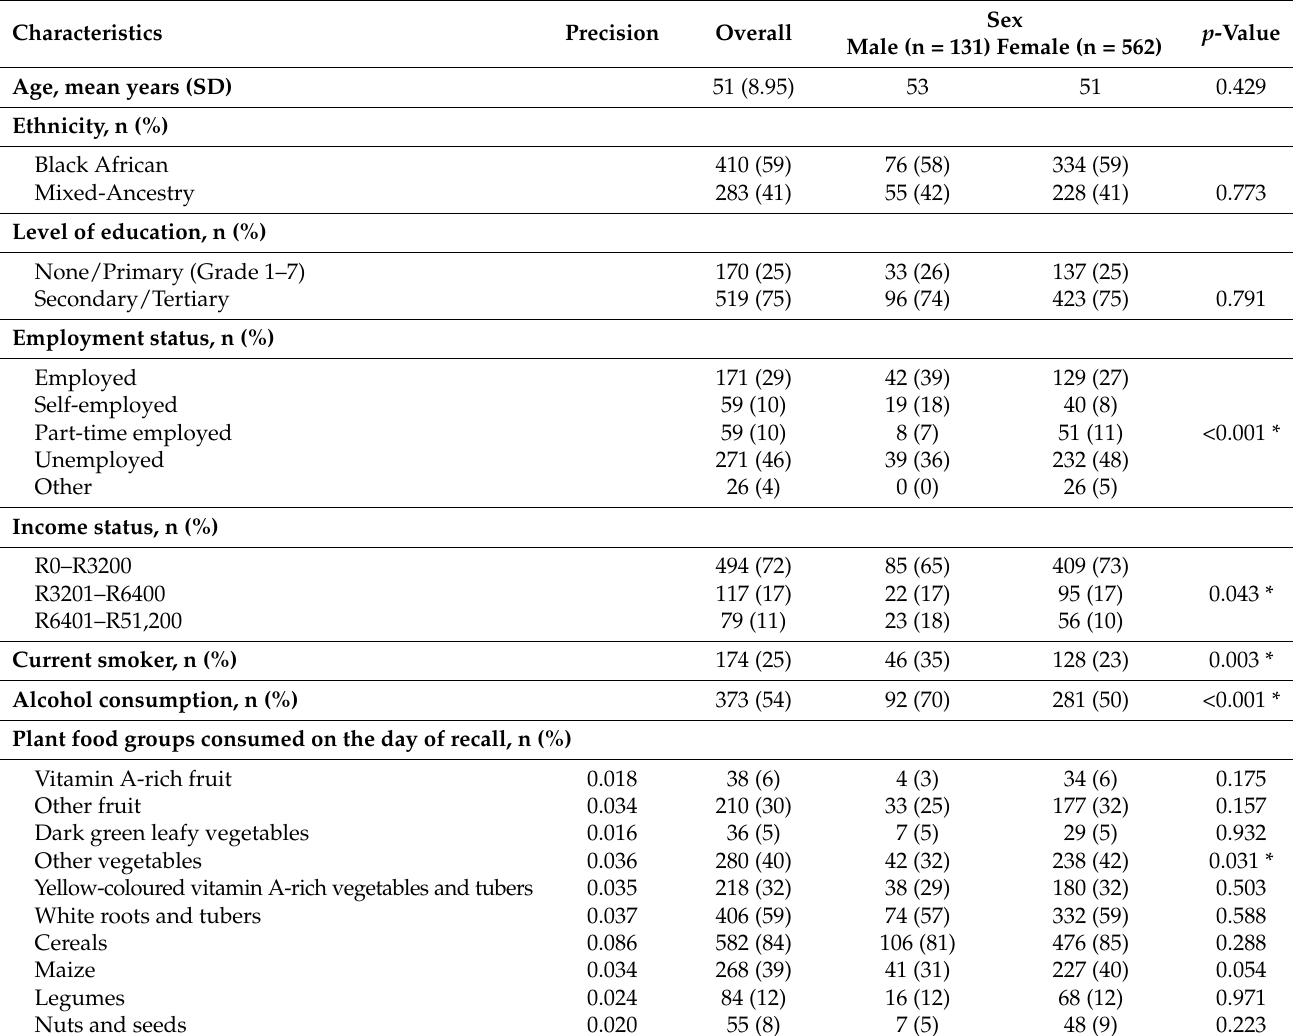
Table 2. Characteristics of study population.